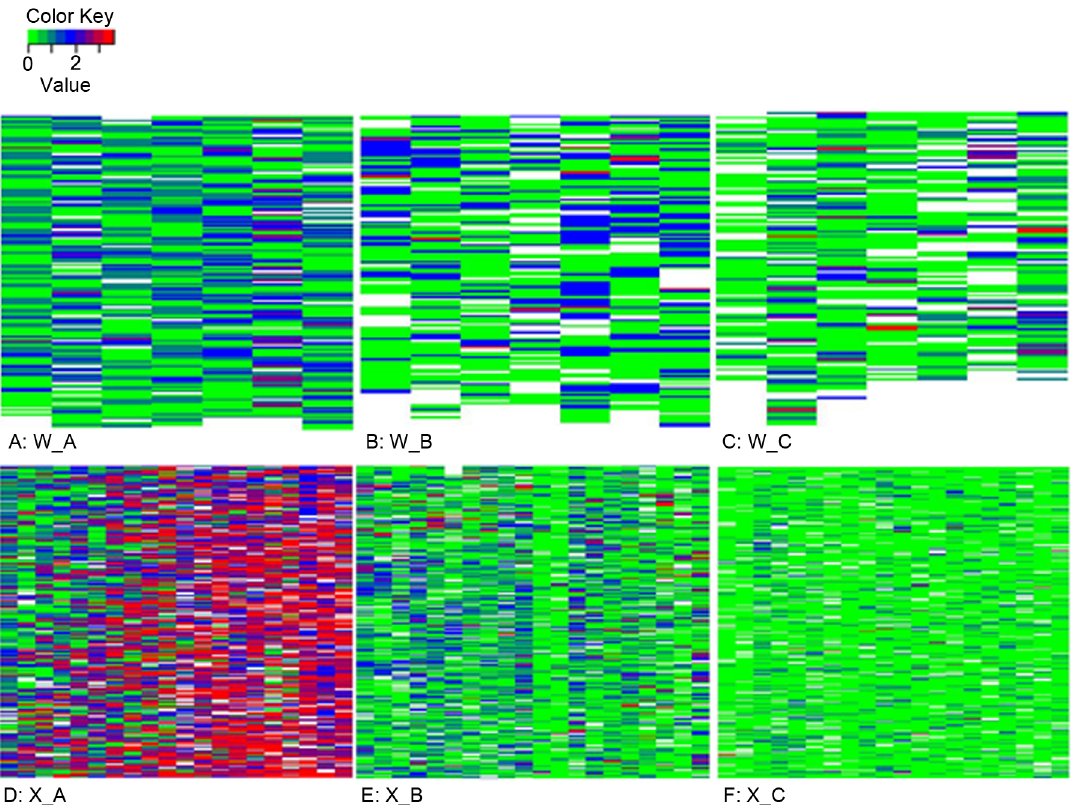
Fig 5. Spatial pattern of wilted cotton plants in commercial fields. Wilt severity was assessed in late August and early September on a scale of 0 – 4: 0 — no symptoms; 1 — leaves with wilt symptoms (cid:2) 25%; 2 — leaves with wilt symptoms > 25% and (cid:2) 50%; 3 — leaves with wilt symptoms > 50% and (cid:2) 75%; and 4 — > 75% leaves with wilt symptoms. Although wilt incidences for W_B and W_C were similar (33% vs. 34%), the apparent difference in the heat maps (B-C) was likely due to the differences in number of missing plants in each field: 15% and 23% of plants were missing for W_B and W_C, respectively. White colour indicates a missing plant position.